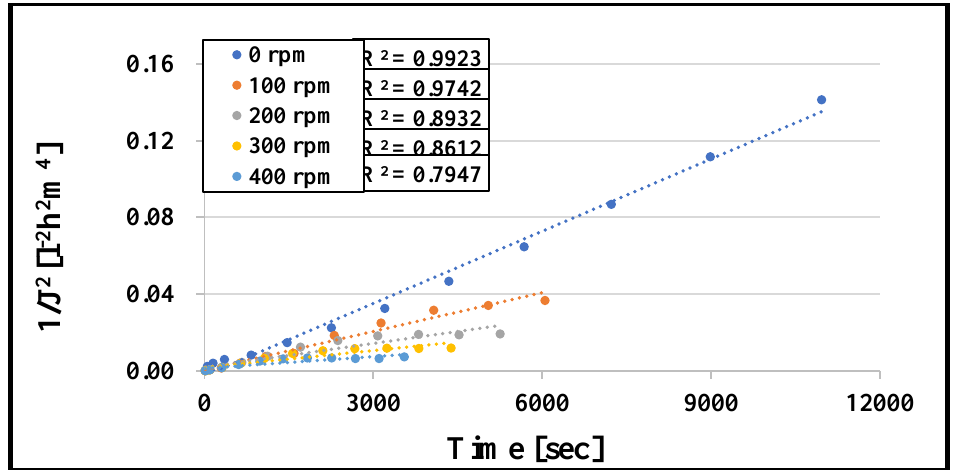
Figure 10. R 2 values of cake layer formation model ( NMWL = 10 kDa). Table 2. R 2 values of Hermia model and reversible resistance ( NMWL = 10 kDa).